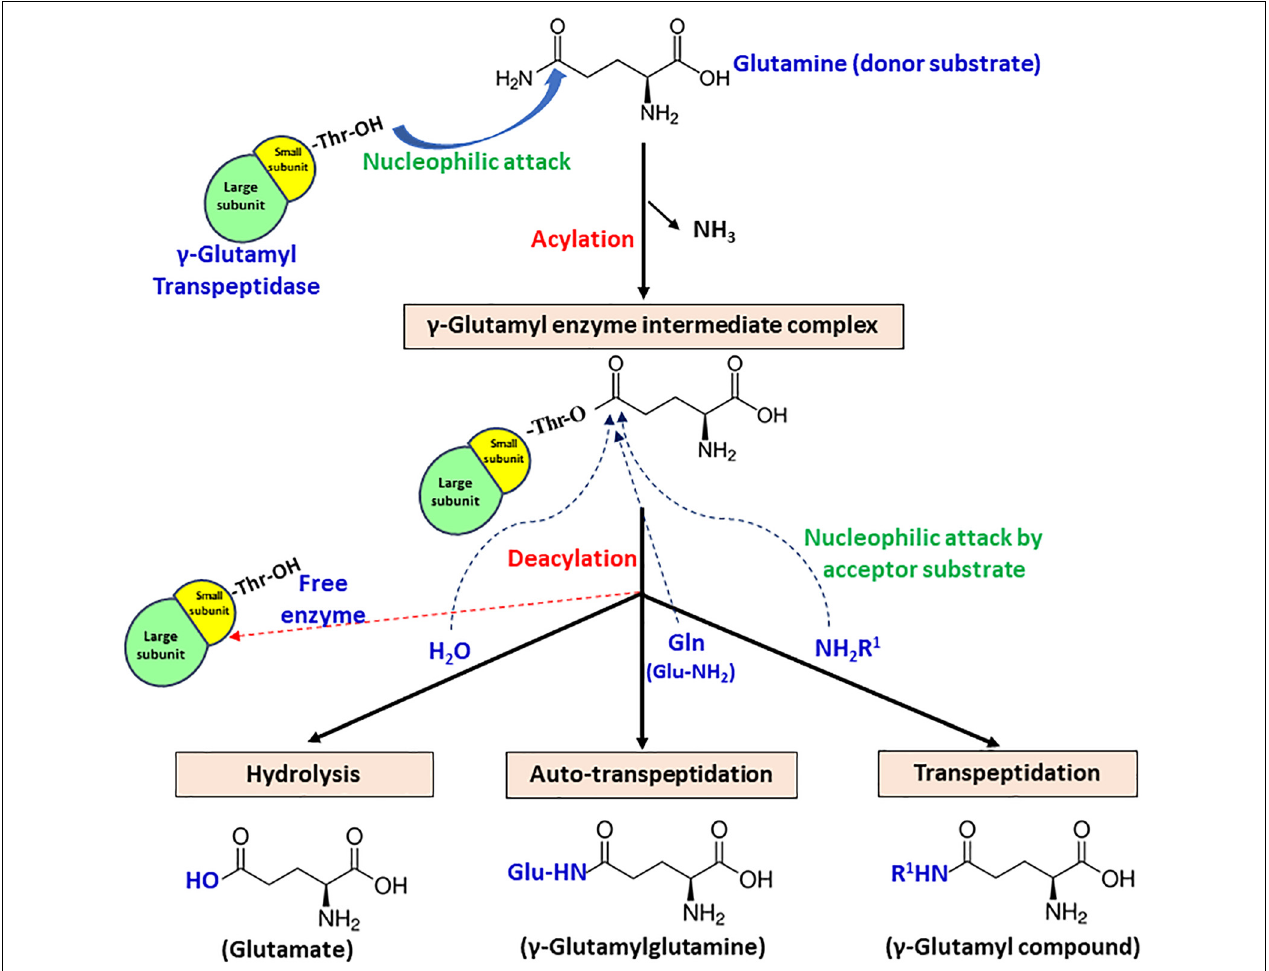
FIGURE 4 | Schematic representation of the proposed catalytic mechanism of gamma-glutamyl transpeptidase (GGT) with glutamine as the γ -glutamyl moiety